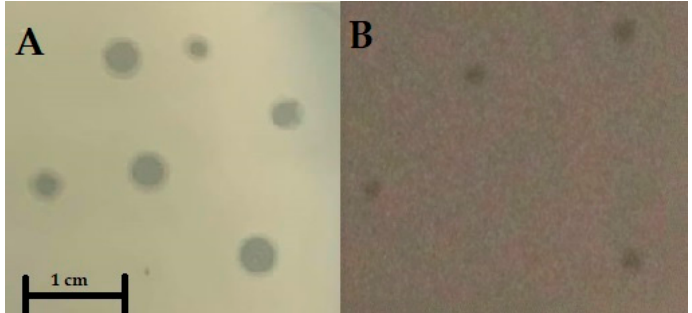
Figure 1. Morphology of plaques of vB_Sen-TO17 ( A ) and vB_Sen-E22 ( B ), formed on a lawn of the S. Typhimurium 13 host. A size bar (representing 1 cm) is shown at the bottom of panel A. Table 1. Morphological characteristics of phages vB_Sen-TO17 and vB_Sen-E22. Experiments were performed using S . Typhimurium 13 as a host.